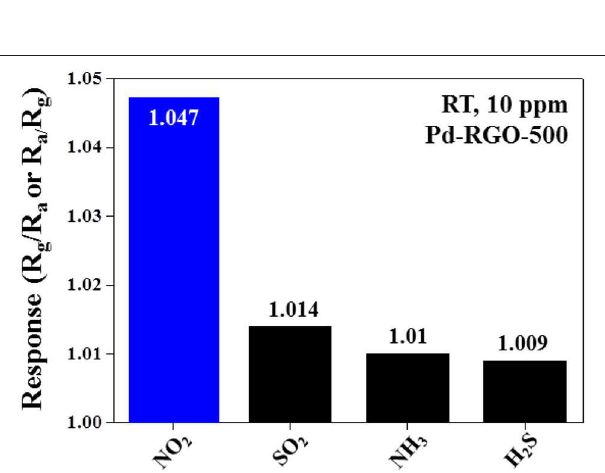
FIGURE 9 | (A) Dynamic responses of the Pd-RGO-500 gas sensor to 2, 5, and 10 ppm NO 2 gas at room temperature. (B) Response of the gas sensor versus the NO 2 gas concentration.